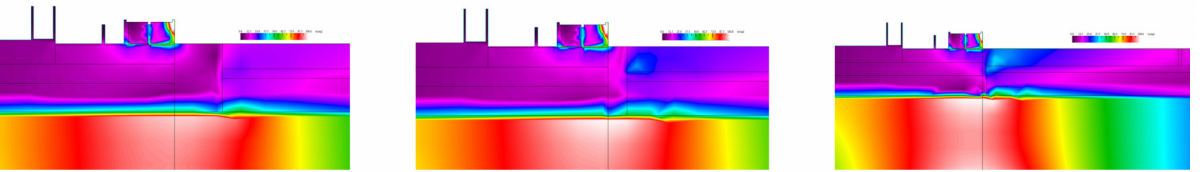
Figure 10. ( a ) Thermal barrier; ( b ) Construction elements. Technical construction elements: (1) lightweight concrete, (2) wood, (3) atmospheric air, (4) insulation barrier, (5) granite, (6) cement mortar, (7) lightweight concrete, (8) reinforced concrete, (9) marble, (10) aluminum.